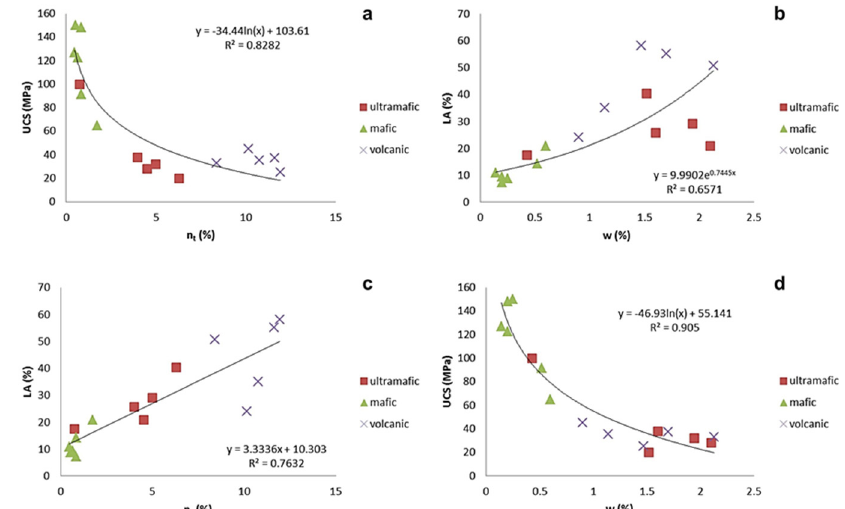
Figure 6. ( a ) The uniaxial compressive strength values ( UCS (MPa)) versus the total porosity ( n t (%)) of the studied rocks; ( b ) the Los Angeles abrasion values ( LA (%)) versus the moisture content ( w (%)) of the studied rocks; ( c ) LA (%) versus n t (%) of the studied rocks; ( d ) the uniaxial compressive strength values ( UCS (MPa)) versus the moisture content ( w (%)) of the studied rocks.